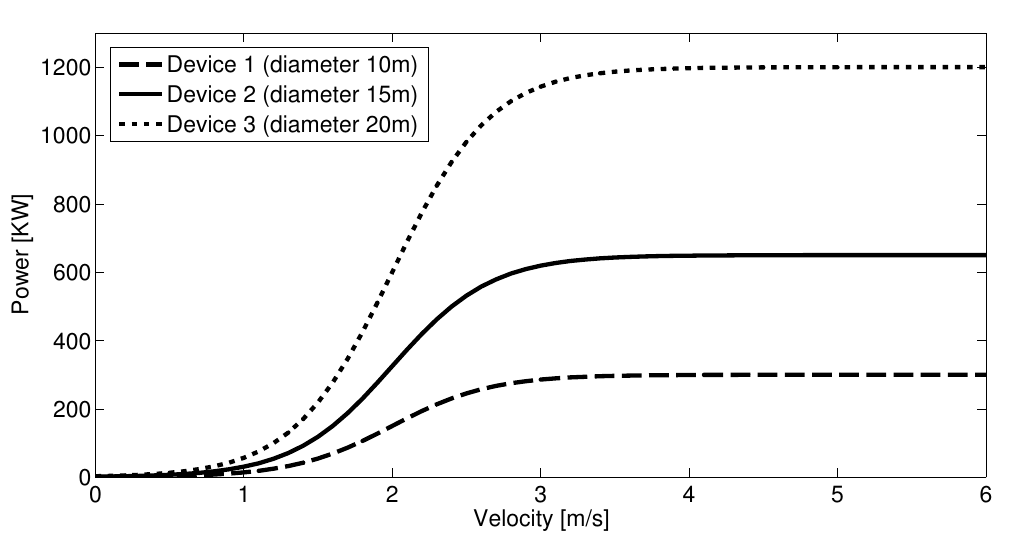
Figure 4. Device curves utilised for the simulations in the current